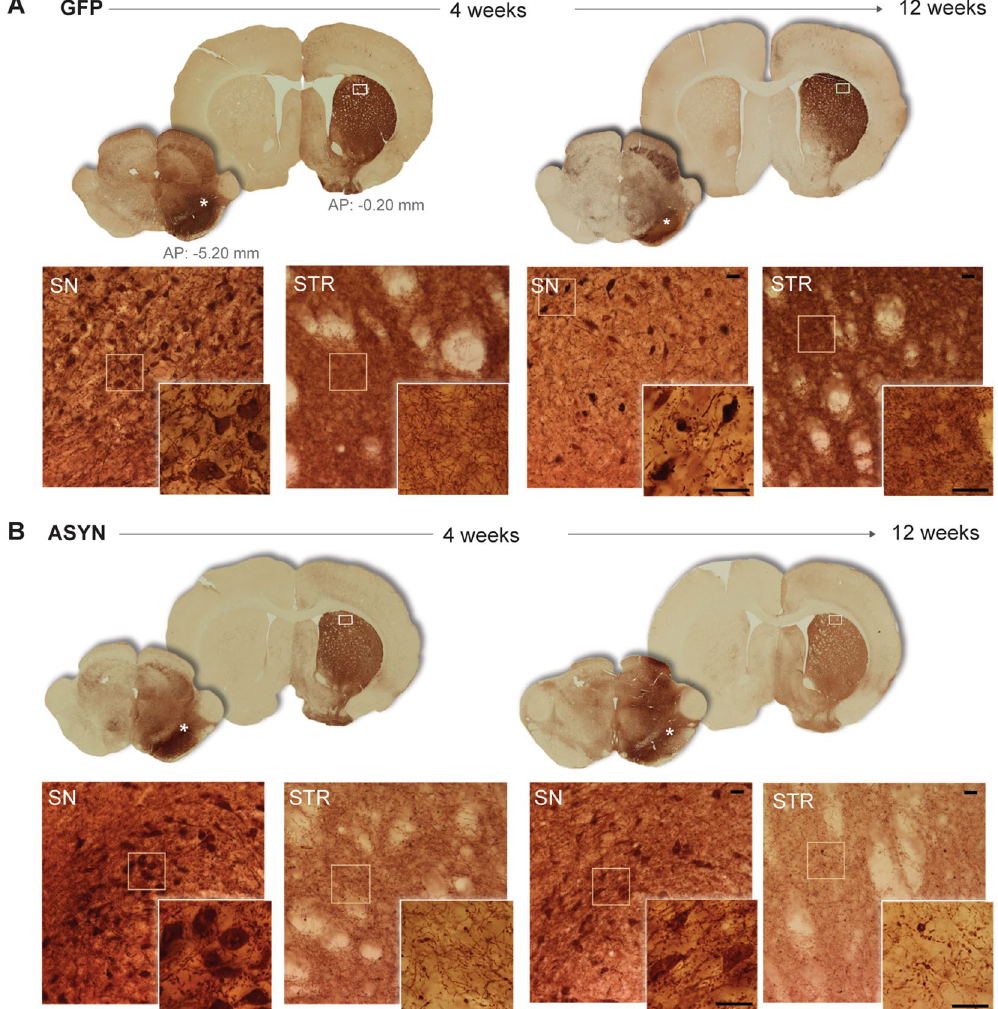
Figure 4. Unilateral transgene expression. ( A ) Schematic views of the coronal sections of substantia nigra (SN) and striatum used for evaluation of transgene expression by immunohistochemistry against GFP ( B ) or human ASYN ( C ). ( A ). Photomicrographs of the areas marked with asterisk in the SN sections or a frame in striatal sections are shown in the bottom rows ( B and C ); inserts display higher magnifications of details framed in the photos. Robust transgene expression was found in the nigrostriatal system at 4 and 12 weeks in both GFP ( B ) and ASYN animals ( C ). In SN, numerous cell bodies resembling neurons expressed the transgene, and this persisted in time in both groups. In striatum, GFP control animals displayed dense immunostaining of the transgene in the striatal terminals, which appeared healthy and of slightly higher intensity as time progressed ( B ). In ASYN animals as early as 4 weeks we observed pathological swelling and thickening of fibers in striatum ( C ). Scale bars in the inserts from 12 weeks photos correspond to 25 um, which also applies to the images from 4